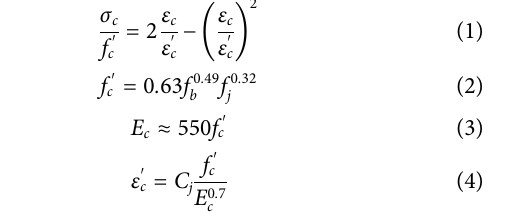
Frontiers in Physics |